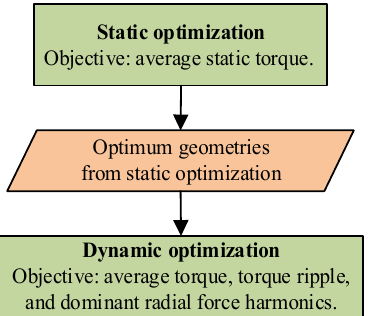
Figure 3. Proposed multi-objective optimization framework [23].